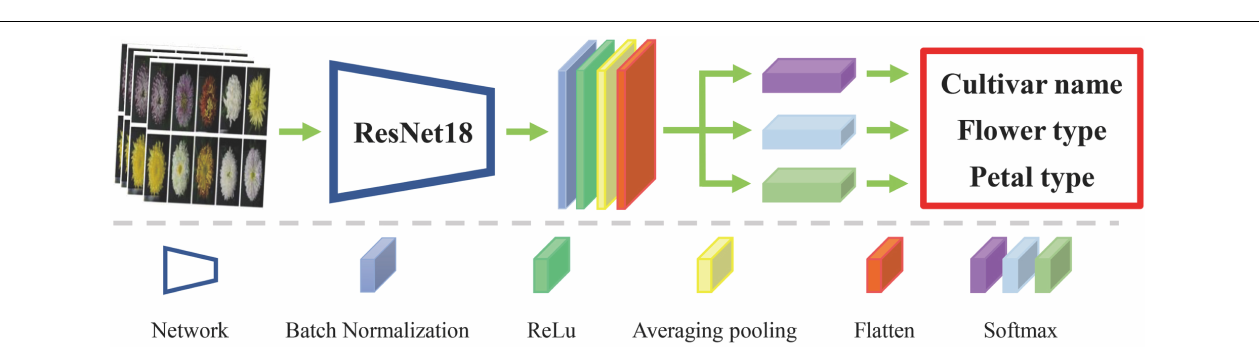
FIGURE 5 | Architecture of the network